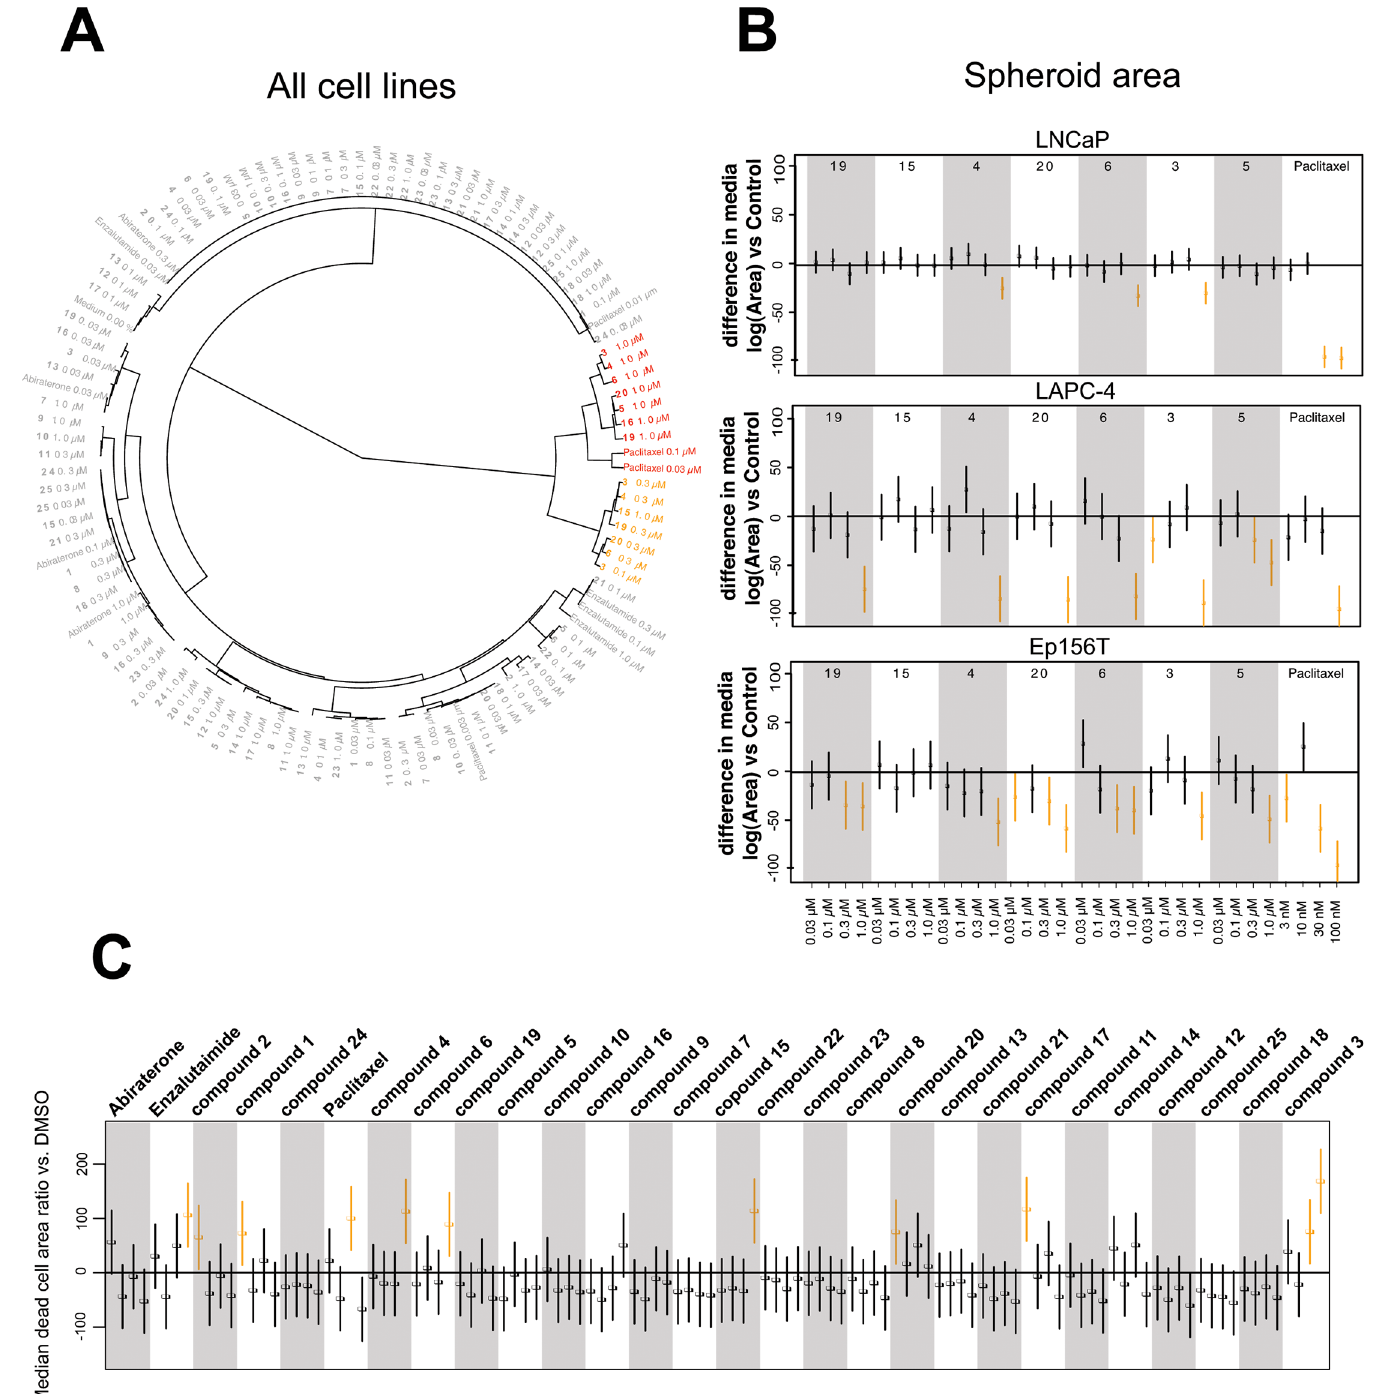
Fig 5. Secondary 3D screens. Experimental betulin derivatives and control compounds were tested across a panel of prostate cancer lines (LNCaP, LAPC- 4) and non-transformed, prostate epithelial cells (EP156T) in 3D culture. A ) The dendrogram is based on three main morphological parameters and combines all data from primary and secondary 3D screens. Effective compound treatments are indicated in red and yellow, yellow being the most invasion- specific. B ) Boxplots showing the impact of selected compounds on spheroid size (Area). Data scaling: as described in Fig 4 C ) Effects of all betulin derivatives and control compounds on cell death (number of dead